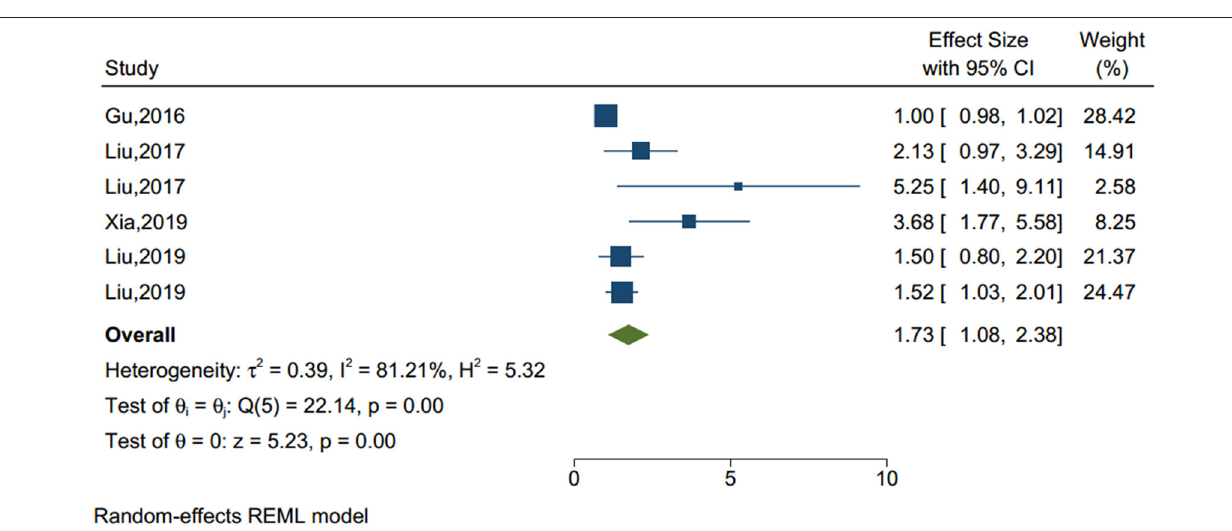
FIGURE 5 | Forest plot of studies including sleep disturbance